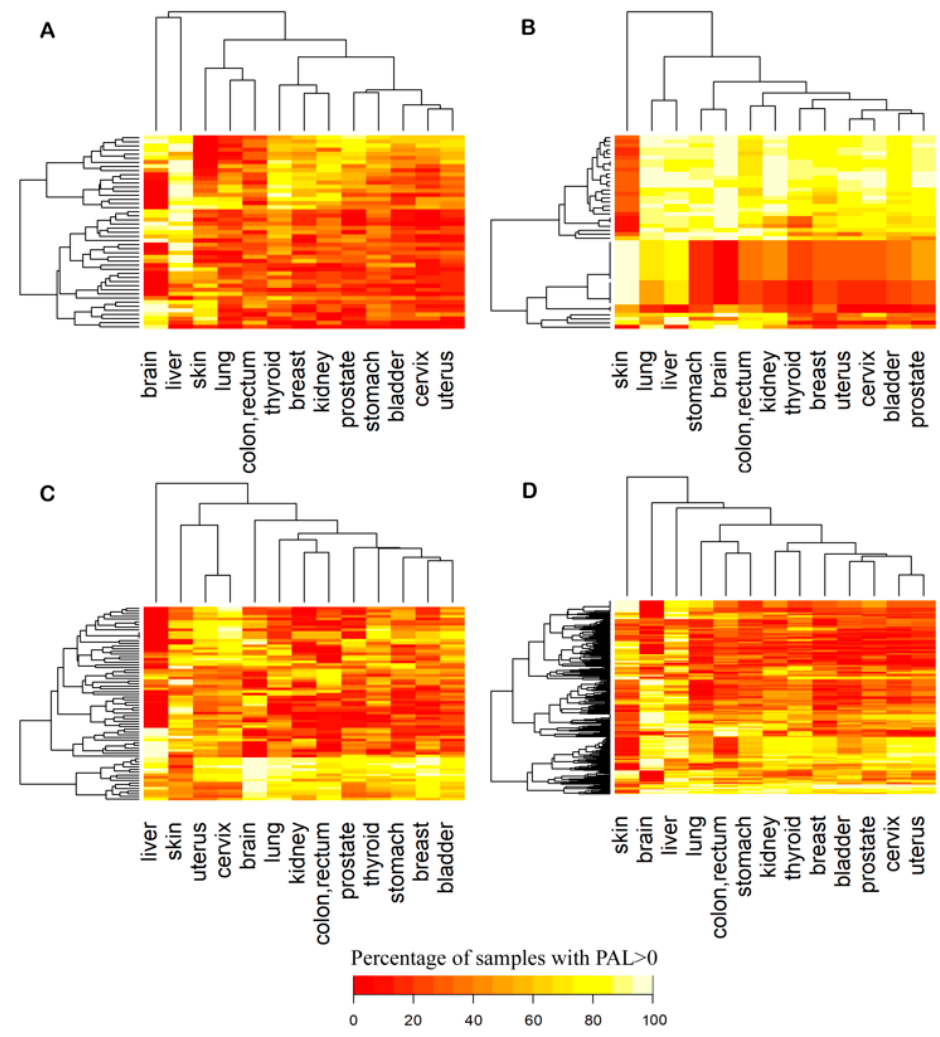
Figure 8. Percentage shares of cancer samples with PAL > 0 in thirteen cancer types for: ( A ) cytoskeleton, ( B ) DNA repair, ( C ) metabolic, ( D ) signaling pathways under investigation. For every pathway, color scale corresponds to percentage of samples where it is upregulated (PAL > 0).